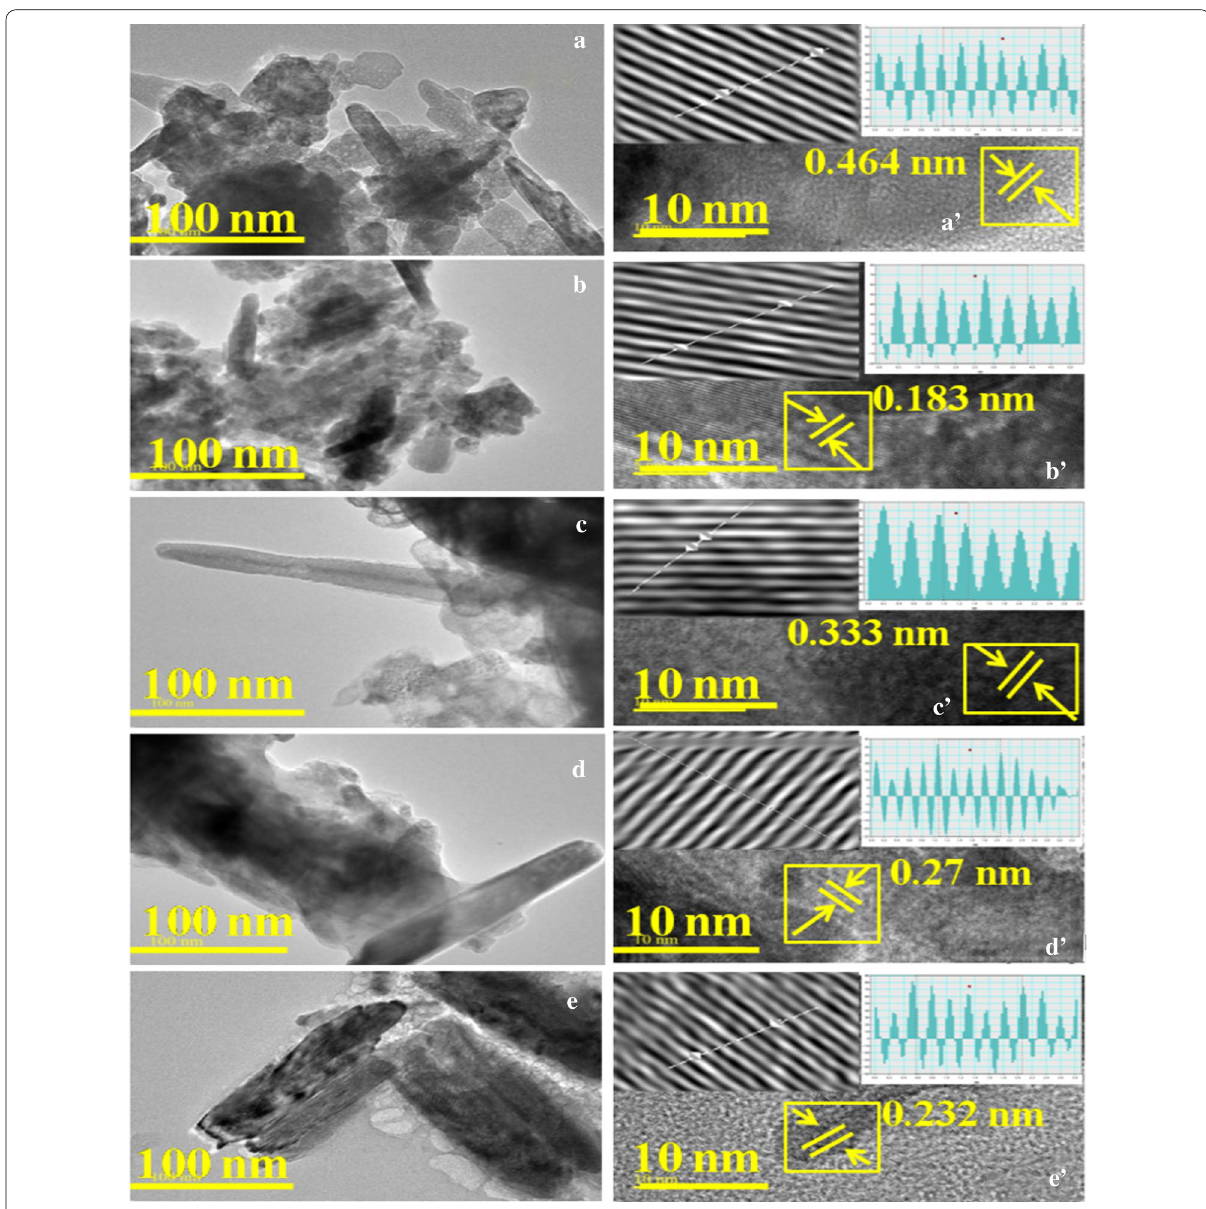
Fig. 4 a–e HR‑TEM images of various concentrations of Mg‑doped ZnO and d‑spacing calculated using HR‑TEM images of Mg‑ZnO a ′ –e ′ with Mg content (2, 4, 6 and 8